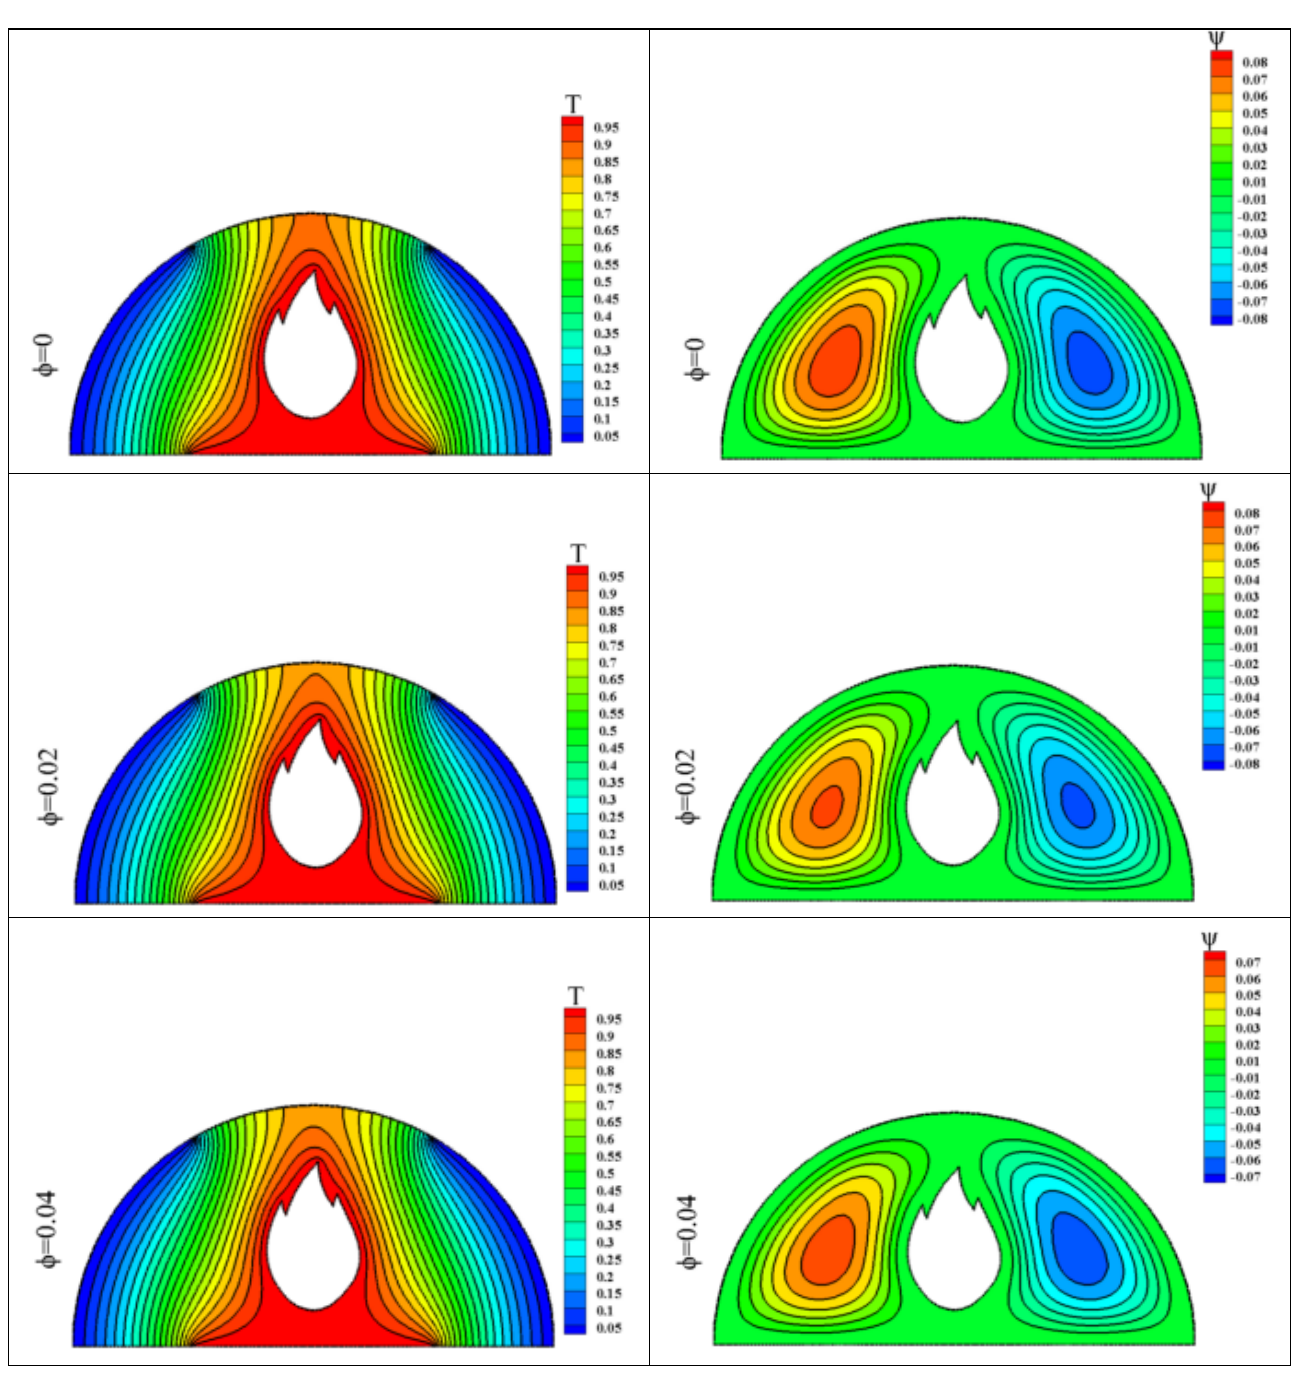
Figure 9. Streamlines ( right ) and isotherms ( left ) in the enclosure for different values of solid volumetric fraction at (Rd = 0.5, Ha = 50, L = 0.2, Da = 10 − 4 and Ra = 10 5 ).